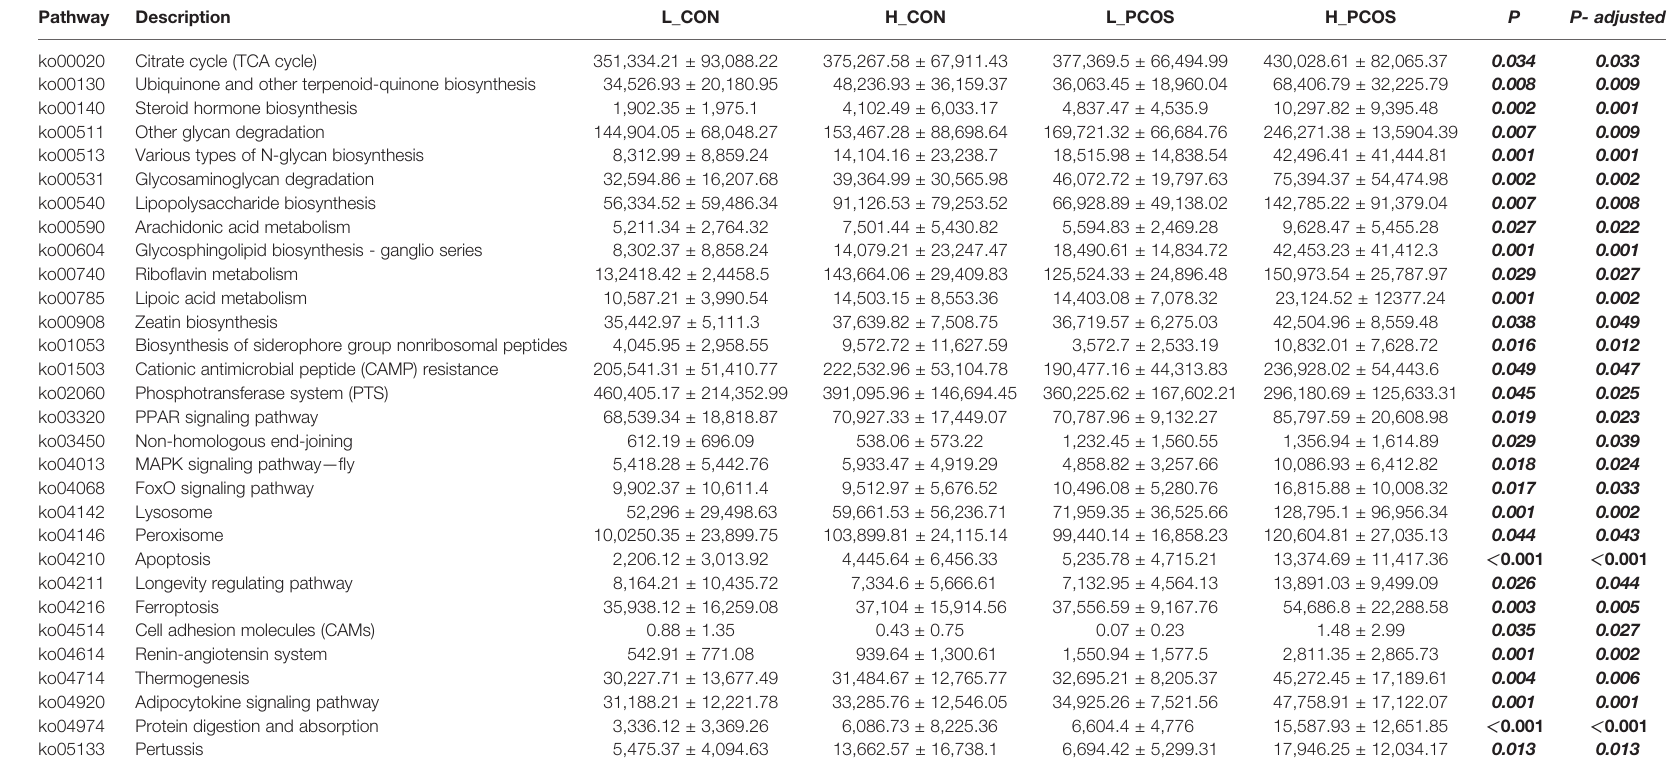
The bold part in the table represents statistics, P < 0.05, with statistical signi fi